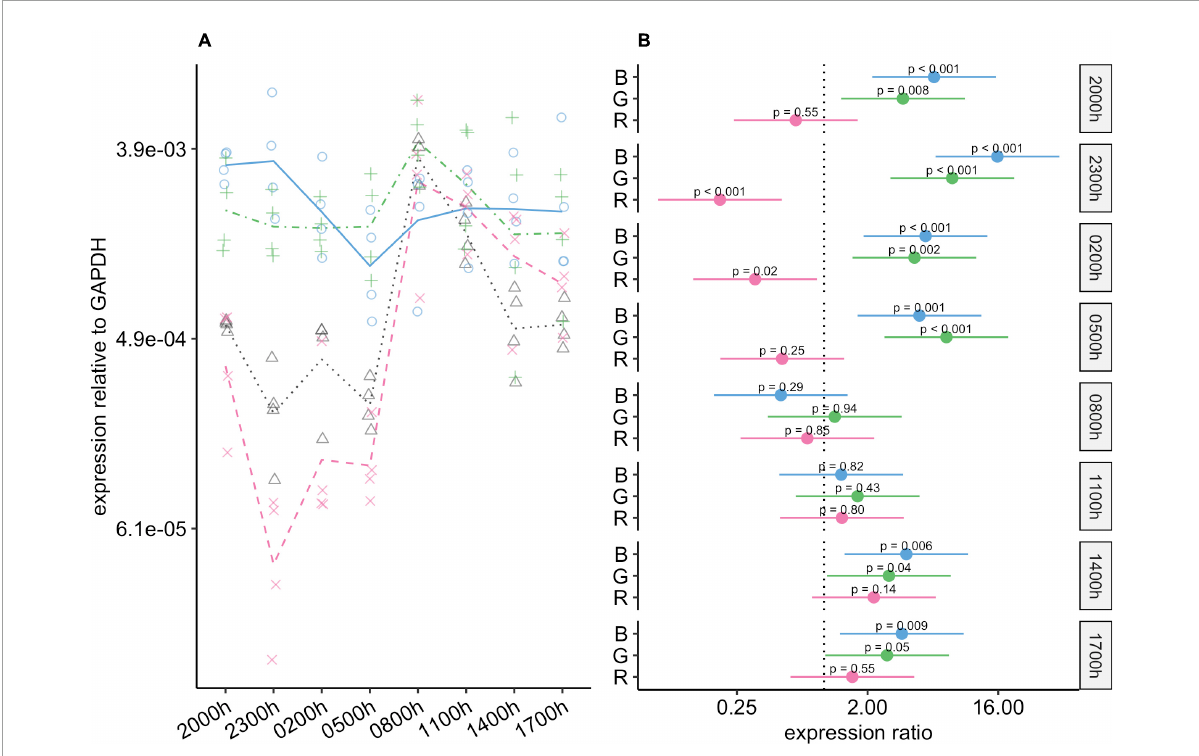
FIGURE6 Effect of monochromatic light exposure on c-Fos mRNA expression in the retinas of Wistar rats. Experimental details were the same as in Figure 1 . P -values and 95% confidence intervals were calculated with Dunnett’s test. Note that logarithmic scales are used. (A) Points show gene expression levels in individual rats; lines connect mean values in each group. To facilitate viewing by color-blind readers, different points and line types were used: control group, dotted line ( •• ) and triangles; red-light group, dashed line (– –) and x-marks; green-light group, dot-dash line ( • –) and crosses; blue-light group, solid line and circles. (B) Points show differences between group means; error bars show the 95% confidence interval for each difference. Abbreviations indicate which group is being compared to the control group: B, blue-light group; G, green-light group; R, red-light